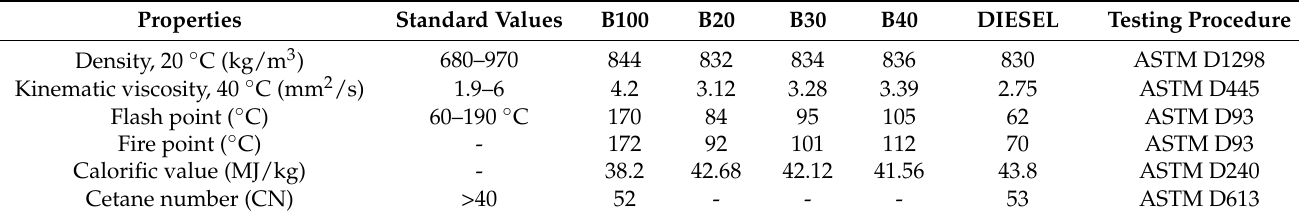
Table 2. Properties diesel–PKO biodiesel blends and neat diesel